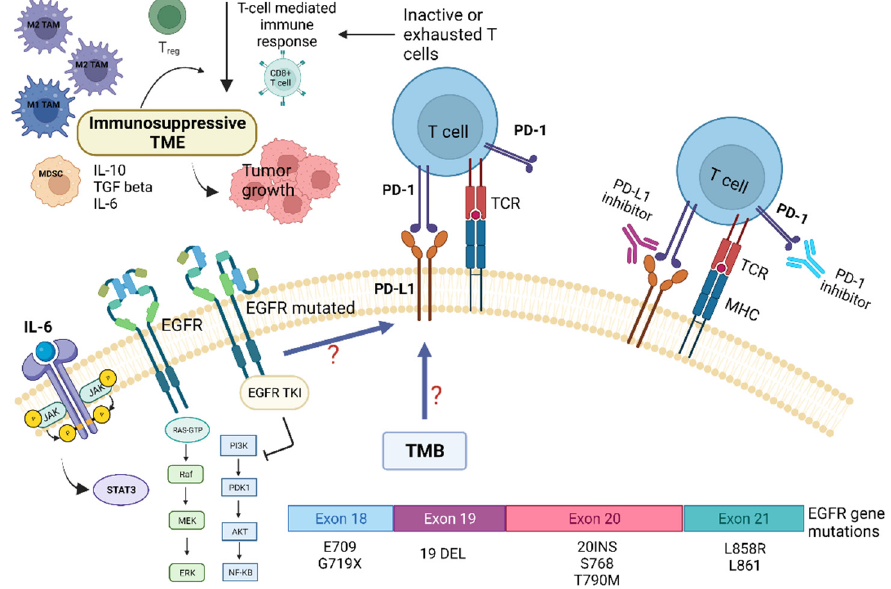
Figure 2. Role of tumor microenvironment in EGFR-mutated NSCLC in influencing resistance pathways to targeted TKI treatment and potential targets for immunotherapy. EGFR mutations are associated with immunosuppressive TME, lower tumor-mutation burden (TMB), and increased PD-L1 expression. EGFR mutations may promote cancer immune escape through modulation of the PD-1/PD-L1 pathway, which in turn determine T-cells inactivity and/or exhaustion. This also leads to EGFR-TKI resistance. In addition, EGFR mutations influence several TME components, such as tumor-infiltrating lymphocytes (TILs), Tregs, MDSCs, TAMs, and immunoregulatory/proinflammatory cytokines, i.e., IL-6. The latter, through the activation of the STAT-3 intracellular pathway, contribute to tumor growth and resistance to targeted therapies. Abbreviations: AKT—serine-thre- onine kinase; EGFR, epidermal growth factor receptor; ERK—extracellular signal-regulated kinase;